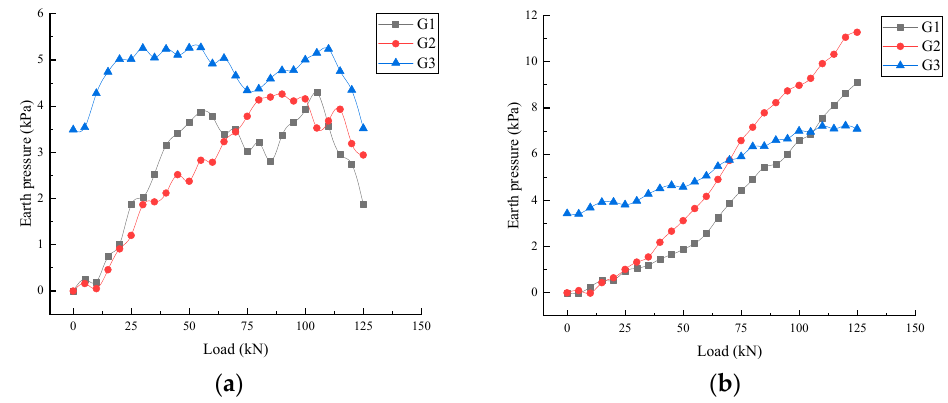
Figure 10. Earth pressure of representative measurement points in each group of tests. ( a ) Measurement point S2. ( b ) Measurement point S4.